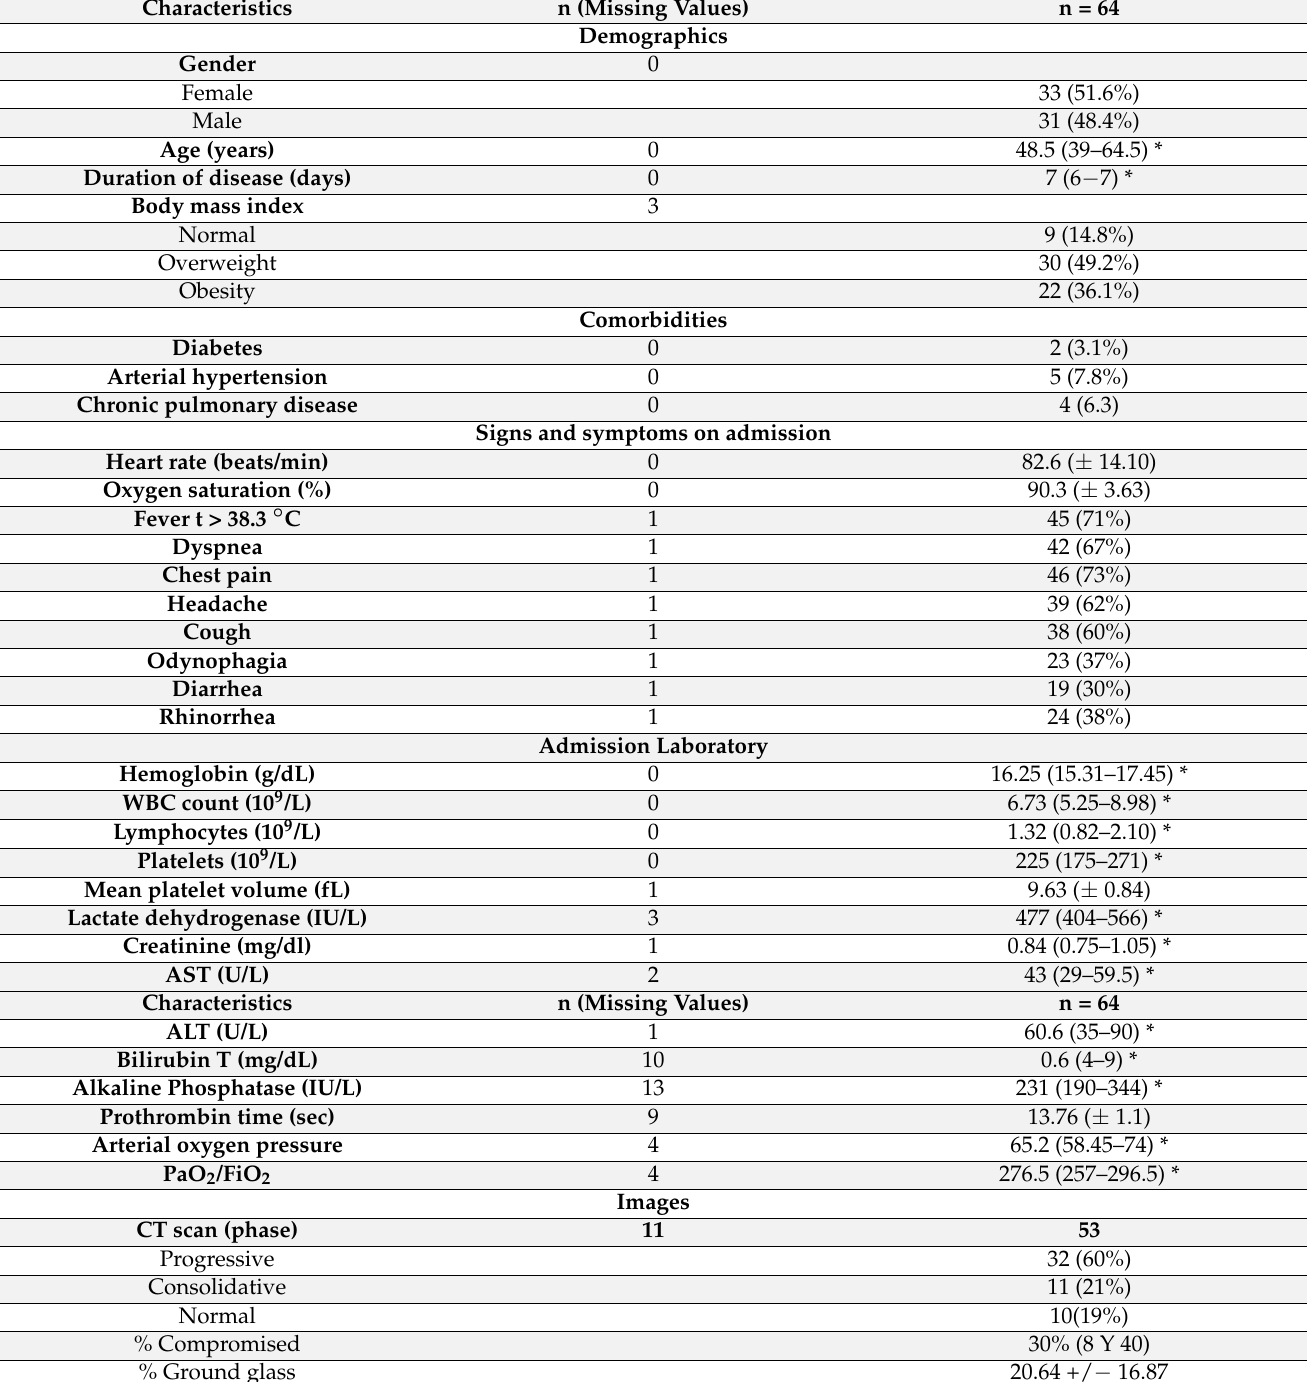
Table 1. Characteristics of the patients on